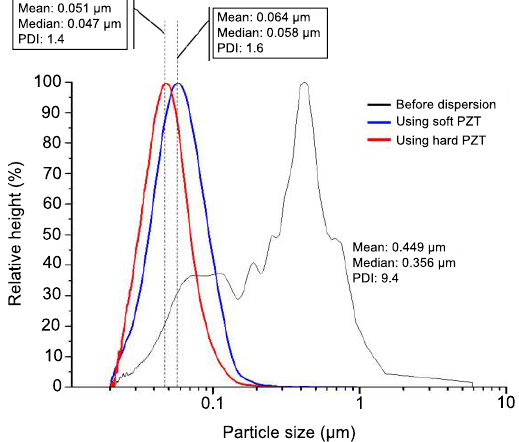
Figure 8. Particle size distributions and polydispersity indexes (PDIs) before and after dispersion using two PZT transducers (black: before dispersion, blue: after dispersion with soft PZT transducer, red: after dispersion with hard PZT transducer).